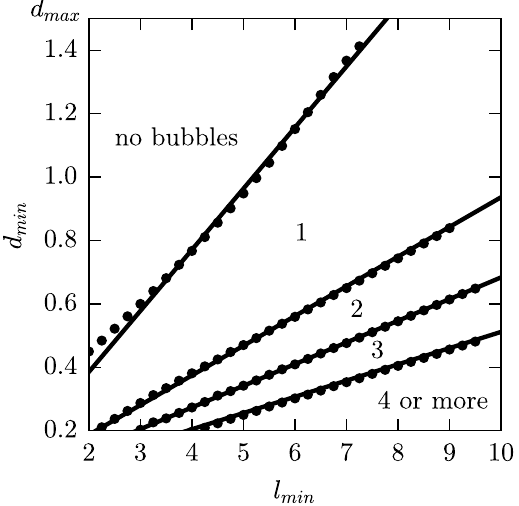
Figure 4. Map showing the regions where layers form with different number of bubbles trapped inside assuming d max = 1.5 a and l max = l min . Threshold points were numerically calculated using an automatic search algorithm. Solid lines, crossing the origin, represent constant l min / d min ratios fitting the